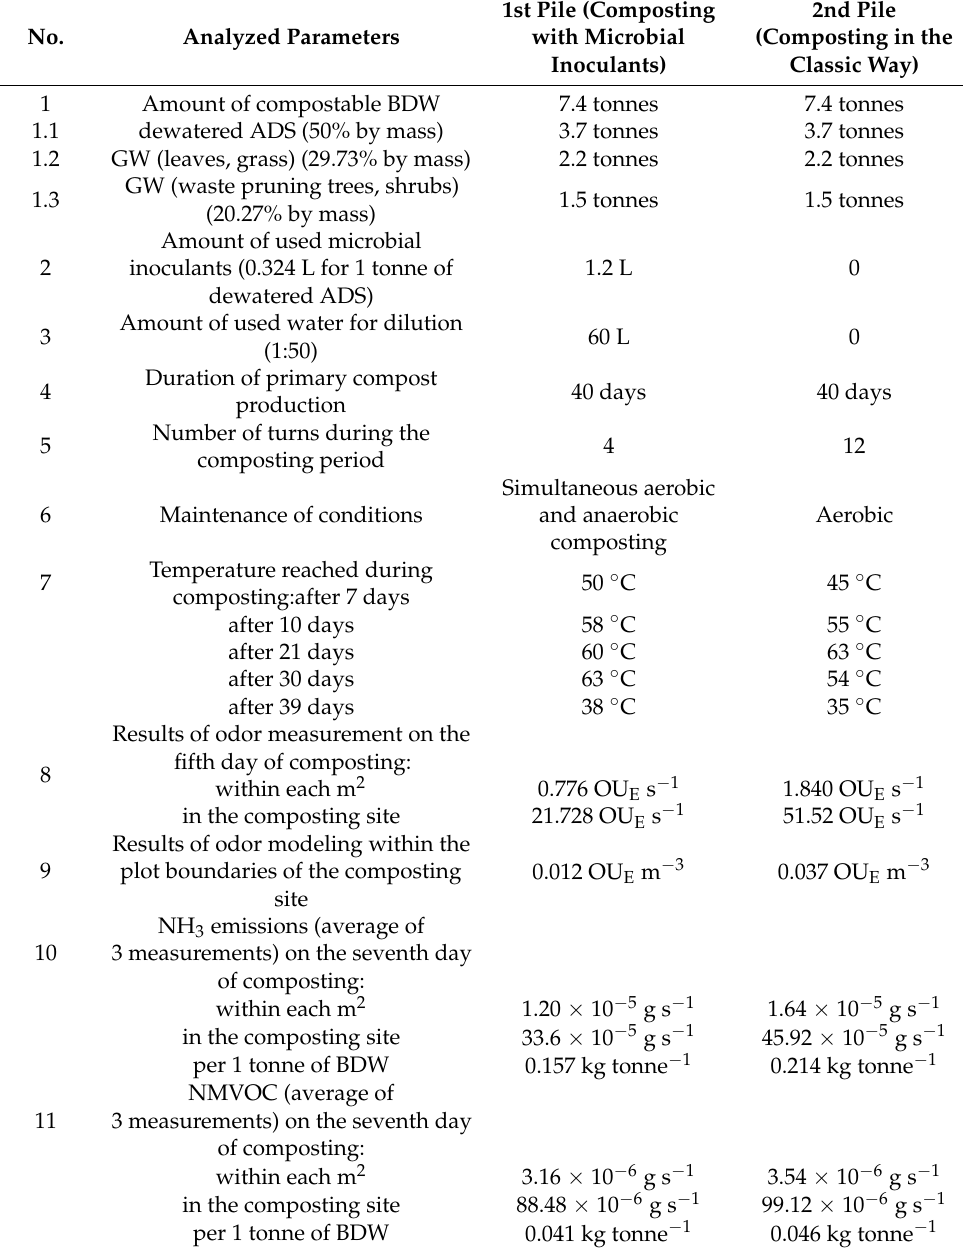
Table 3. Technological parameters of composting processes and results of emission